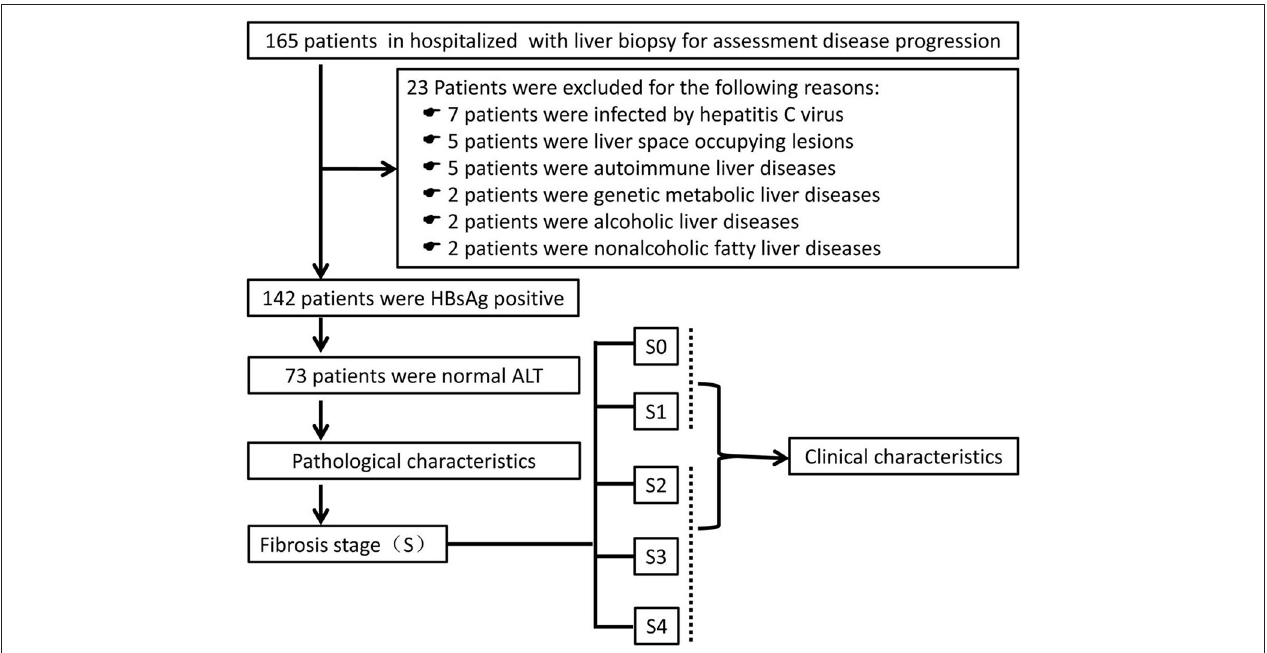
FIGURE 1 | Screening, enrollment and grouping of the study. ALT, alanine aminotransferase; HBsAg, hepatitis B surface